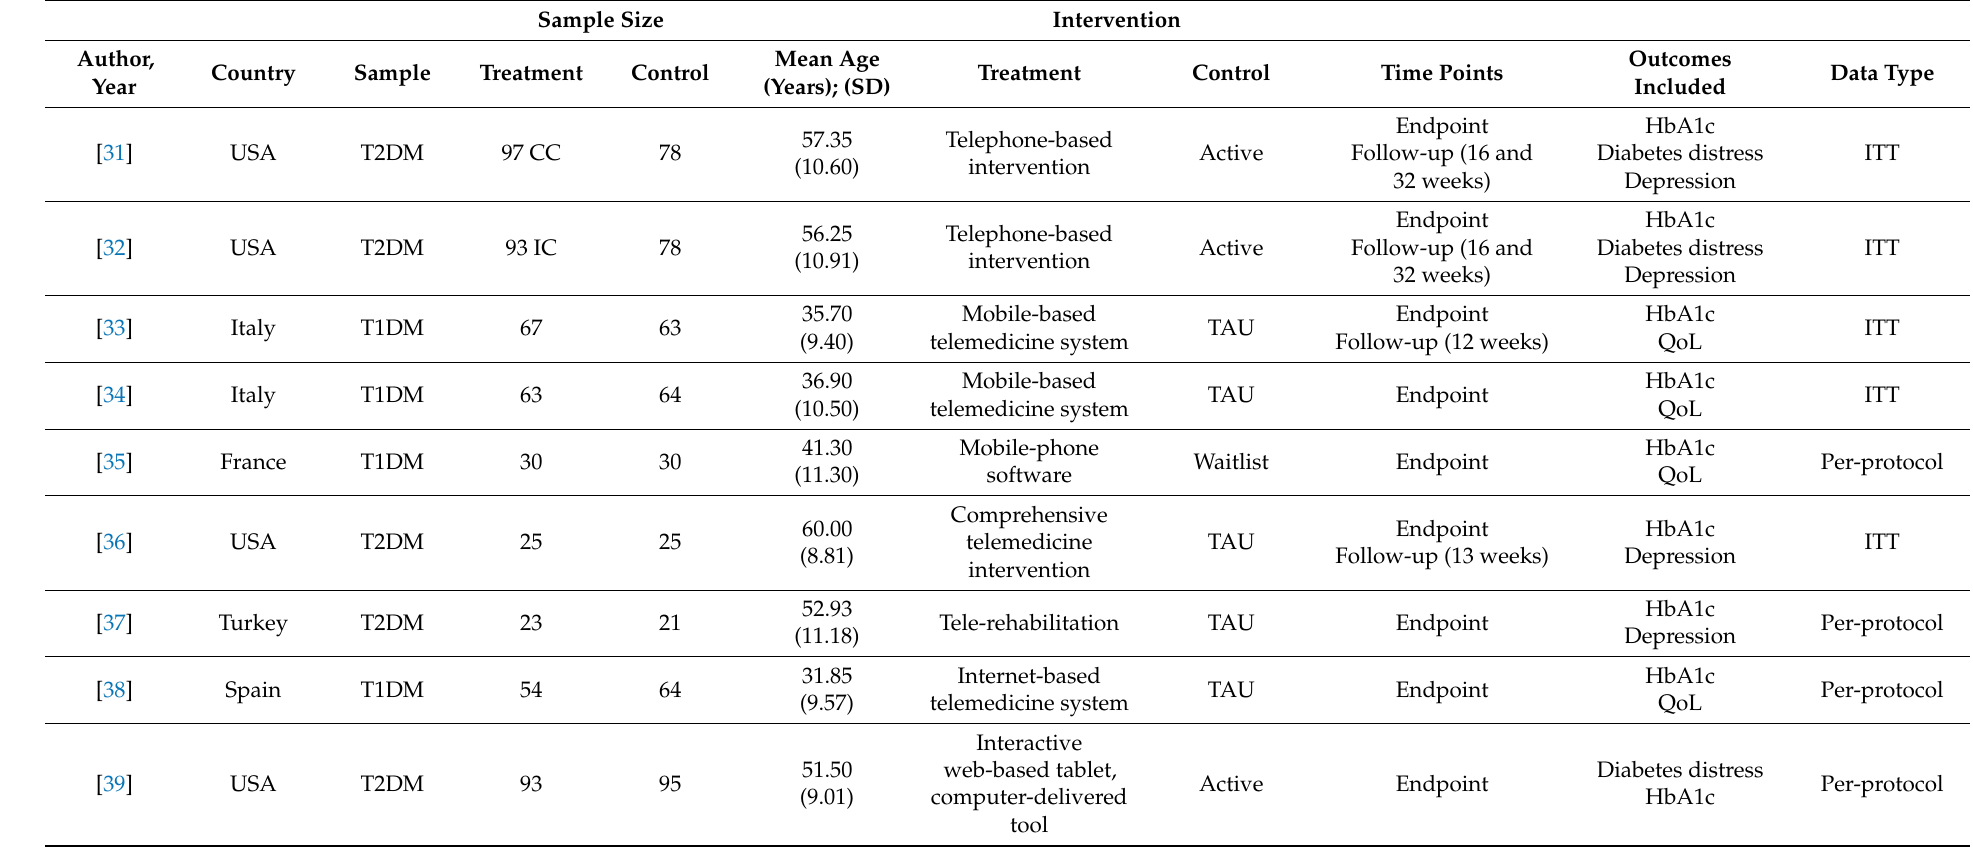
Table 1. Characteristics of the included